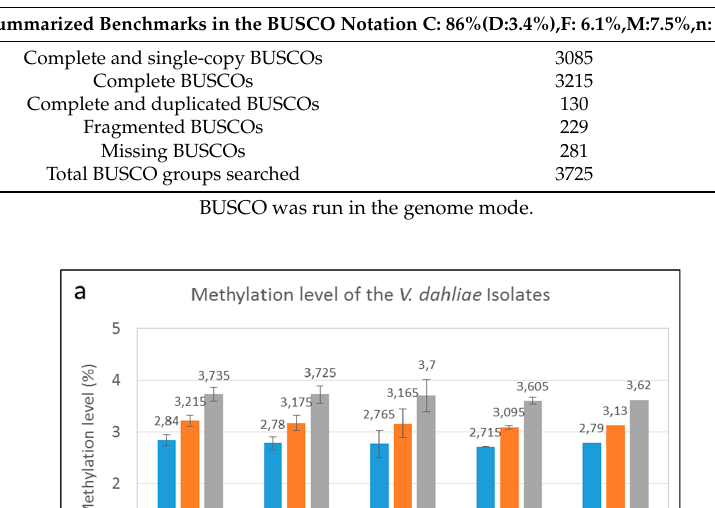
Table 3. Transcriptome quality.